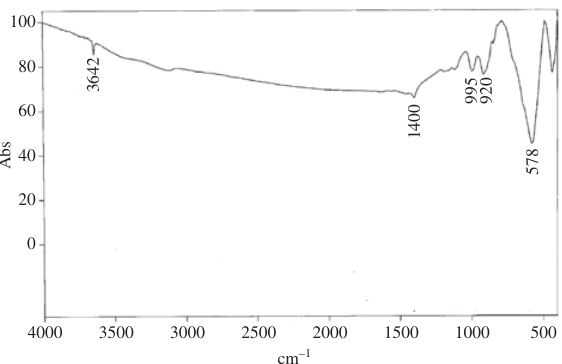
O nanoparticles calcined 12 19